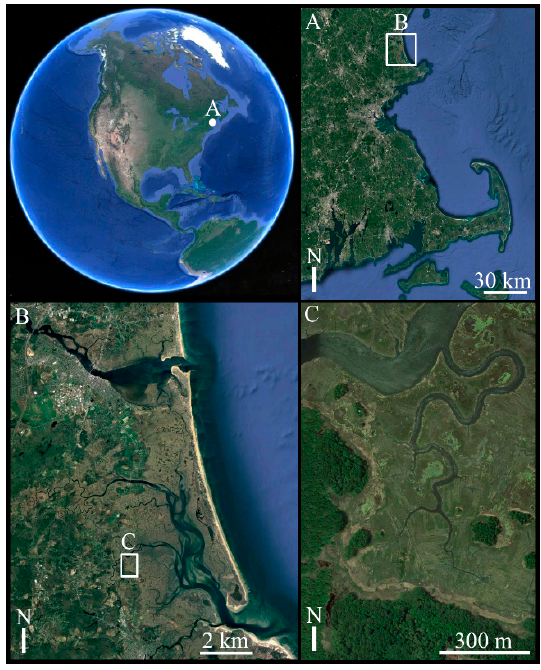
Figure 1. New England, United States (Top left). Plum Island NSF LTER site is close to the Boston, Massachusetts metropolitan area ( A ). Plum Island consists of a barrier island, protecting saltmarsh around several rivers ( B ). Field Site Location next to Rowley River is also the site of the NSF-funded TIDE project, which explored the effects of nitrogen enrichment ( C ). Aerial imagery sources: Google, Landsat, Copernicus and International Bathymetric Chart of the Arctic Ocean (IBCAO) via Google.